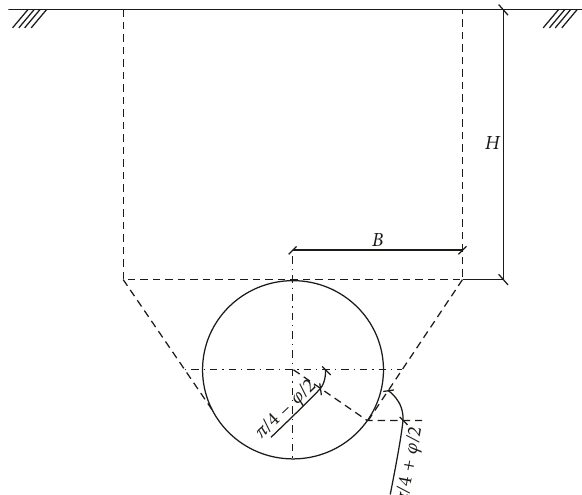
Figure 9: The schematic diagram of the Terzaghi loose earth theory [17].